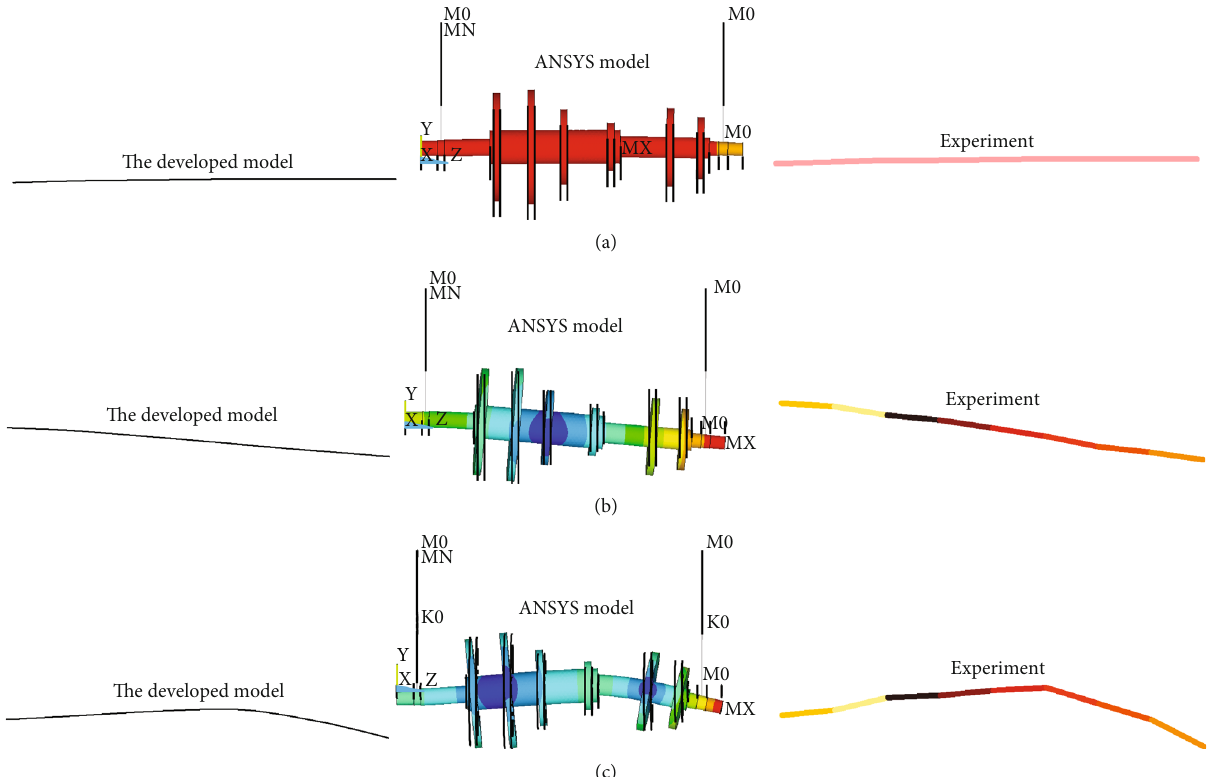
Figure 7: First three model shape of gas-generator rotor: (a) 1st; (b) 2nd; (c)